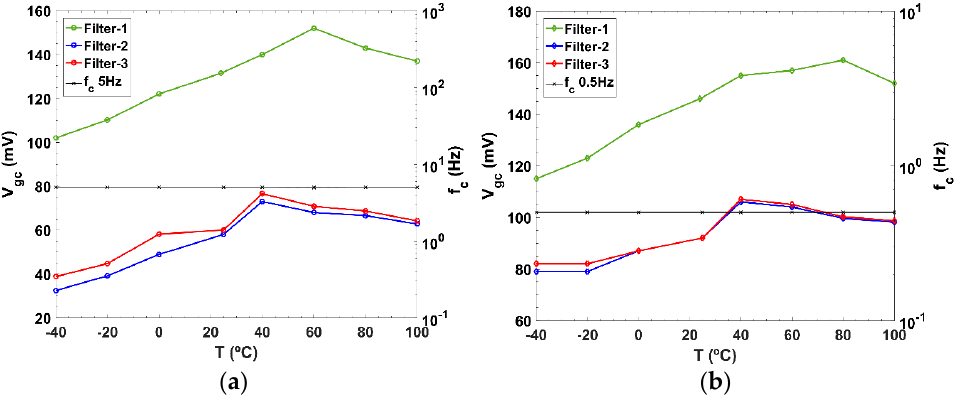
Figure 11. V gc adjusted over T-variations, for the three filters, to keep f c at: ( a ) 5 Hz and ( b ) 0.5 Hz.